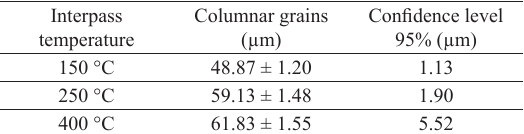
Table 4. Quantitative analysis of the width of columnar grains in the fusion